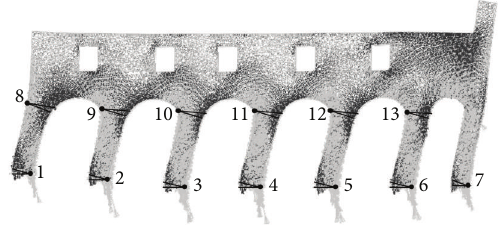
Figure 14: Nonlinear FE analysis: principal stresses with the locationsofcrackopeningsforthenavewallN1-N2.Whiteandblack colour corresponds to compression and tension areas, respectively.